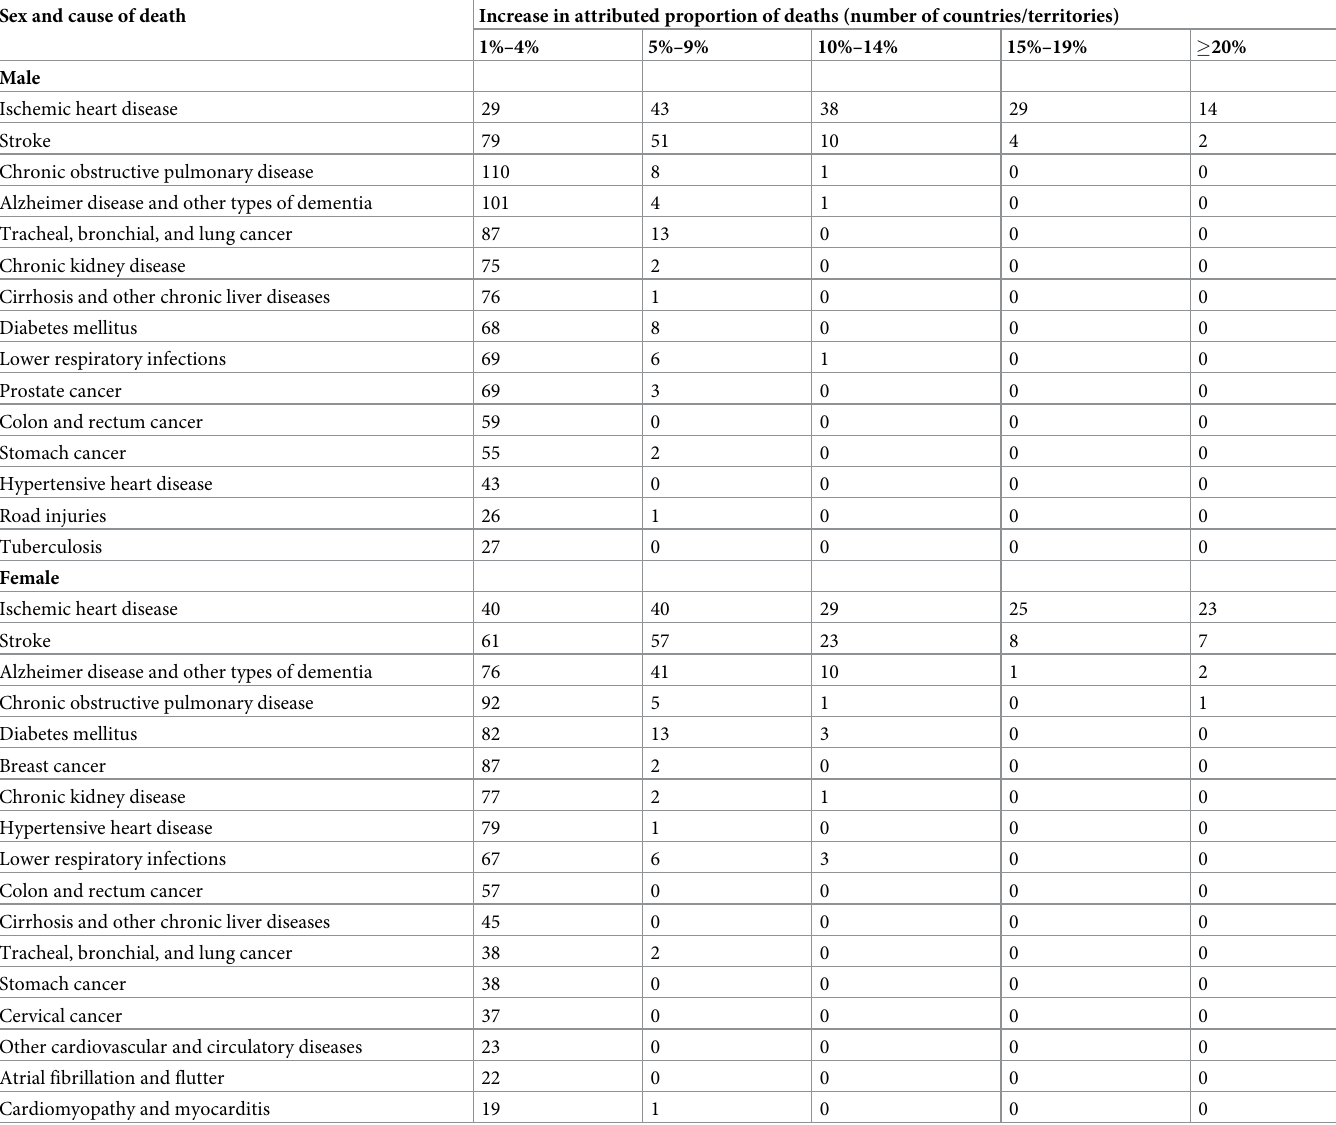
Table 3. Number of countries and territories with different increases in cause-specific proportions of deaths associated with population ageing between 1990 and 2017. Sex and cause of death Increase in attributed proportion of deaths (number of